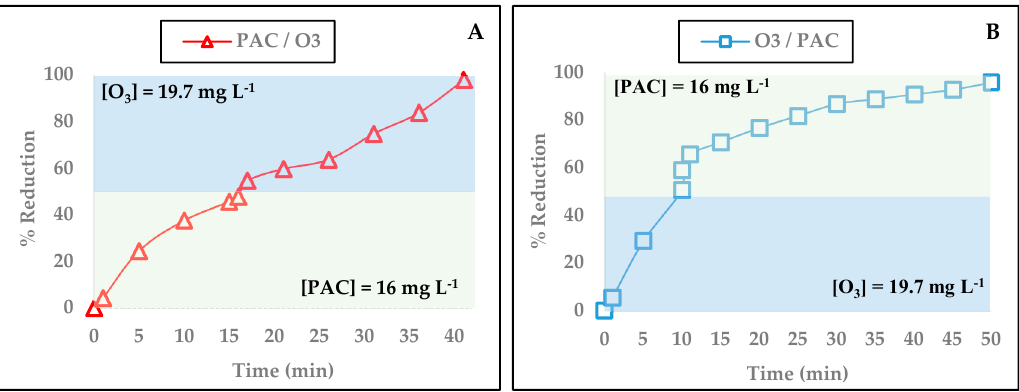
Figure 8. Evolution of simazine reduction over time for combined treatments: ( A ) Experimental conditions PAC/O 3 : [Simazine 0 ] = 0.7 mg L − 1 ; [PAC] = 16 mg L − 1 ; [O 3 ] = 19.7 mg L − 1 ; pH 0 6.7; pH (20 min) 4.3–4.5; T = 25 °C. ( B ) Experimental conditions O 3 /PAC: [Simazine 0 ] = 0.7 mg L − 1 ; [O 3 ] = 19.7 mg L − 1 ; [PAC] = 16 mg L − 1 ; pH 0 6.7; pH (20 min) 5.0–5.2; T = 25 °C.